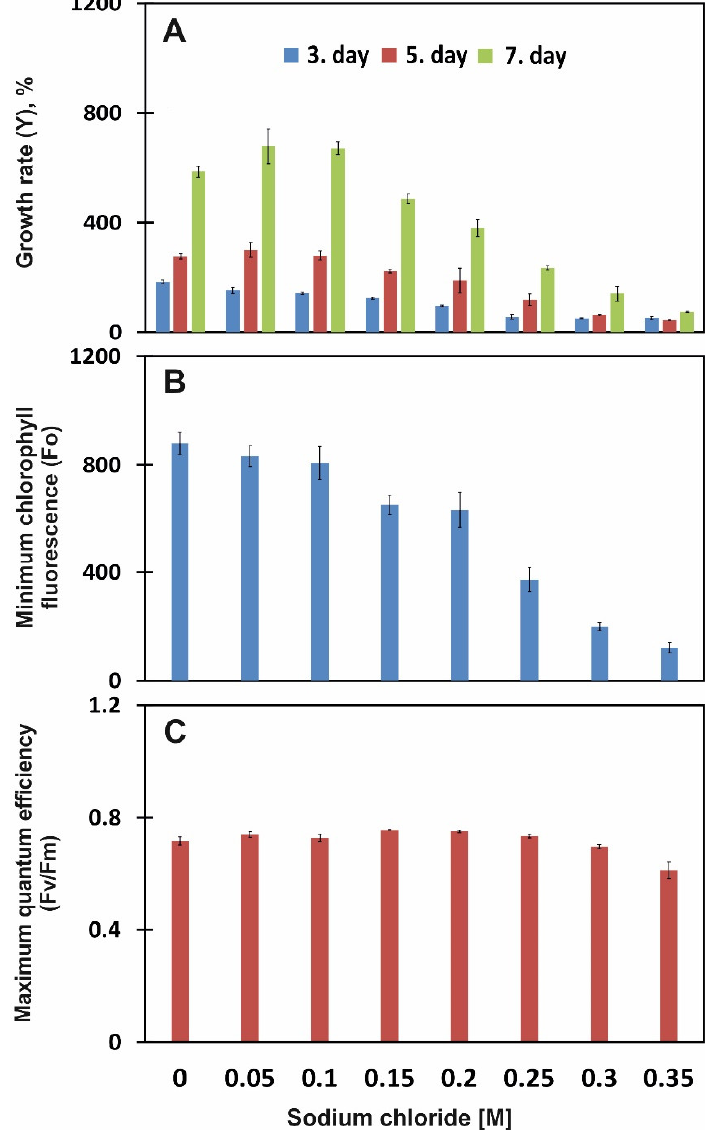
Figure 1. ( A )—Growth rate (Y), ( B )—minimum chlorophyll fluorescence (Fo) and ( C )—maximum quantum efficiency (Fv/Fm) of PSII of algae ( Pseudokirchneriella subcapitata ) exposed to sodium chloride (NaCl) concentrations (0–0.35 M). Data points represent the mean ± SD, n = 6. The significantly reduction of algal Y by 50% (EC 50 ) occurred at a NaCl concentration of 0.21 M (Tables 2 and 3). On the other hand, the lowest Y 3 was noted from the NaCl concentration of 0.25 M to the highest concentration of 0.35 M. At these concentrations, the algal Y amounted to an average of 53% (Figure 1). On day 5 of the experiment, the algal Y in the control sample was higher than on day 3 and amounted to 276.93%. On day 5 of the exposure, the lowest tested NaCl concentra- tions (0.05 M and 0.10 M) slightly insignificantly stimulated the algal growth. At these concentrations, the Y were 300.16% and 280.13%, respectively (Figure 1, Table 2). The stim- ulation of growth resulted in a slightly higher effective concentration of 0.24 M which significantly inhibited the algal growth by 50% (Table 3). At the highest tested NaCl con- centration (0.35 M), the algal Y rate reached a value of 44% and was over six times lower than that for the control algae (Figure 1).